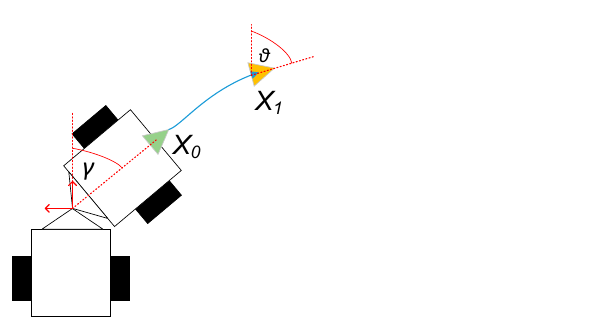
Figure 10. Graphic representation of the kinematic variables of the vehicle.